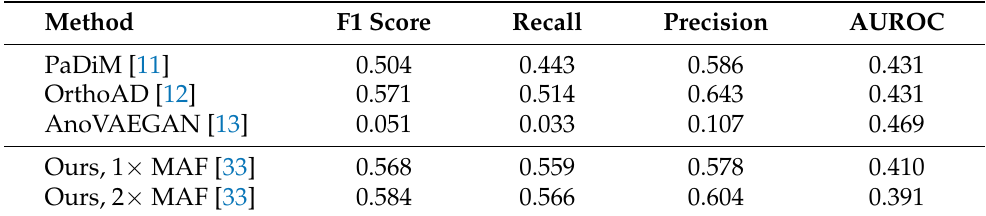
Table 2. Results on the Kelonia dataset. All the models have been trained using the same set of 1000 training images.